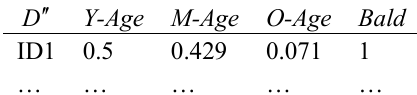
Table 5: After Fuzzy Normalization.